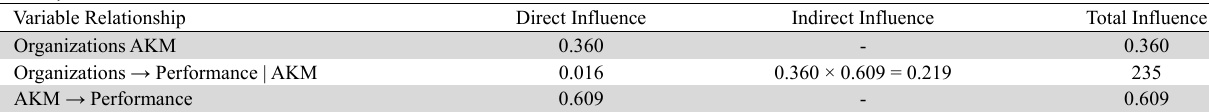
Direct, Indirect and Total